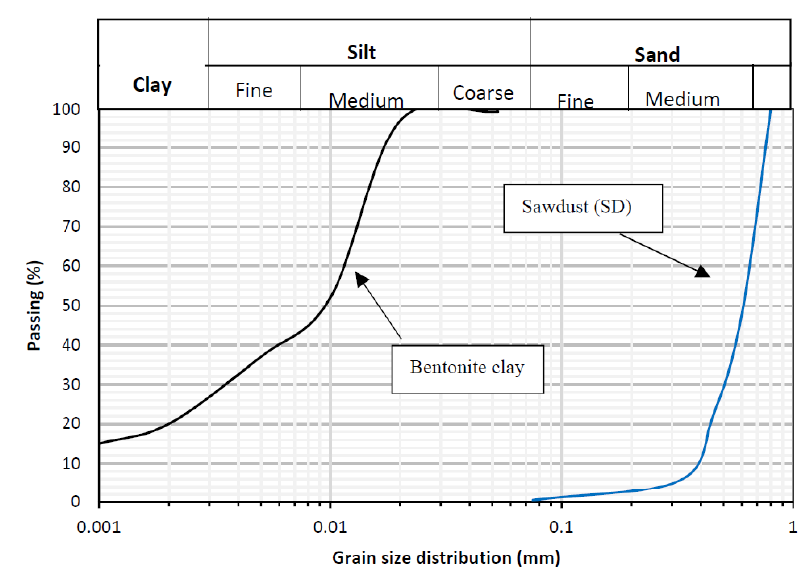
Figure 1. Particle size distribution (PSD) of the used bentonite clay and the used sawdust (SD). Materials 2020 , 13 , x FOR PEER REVIEW